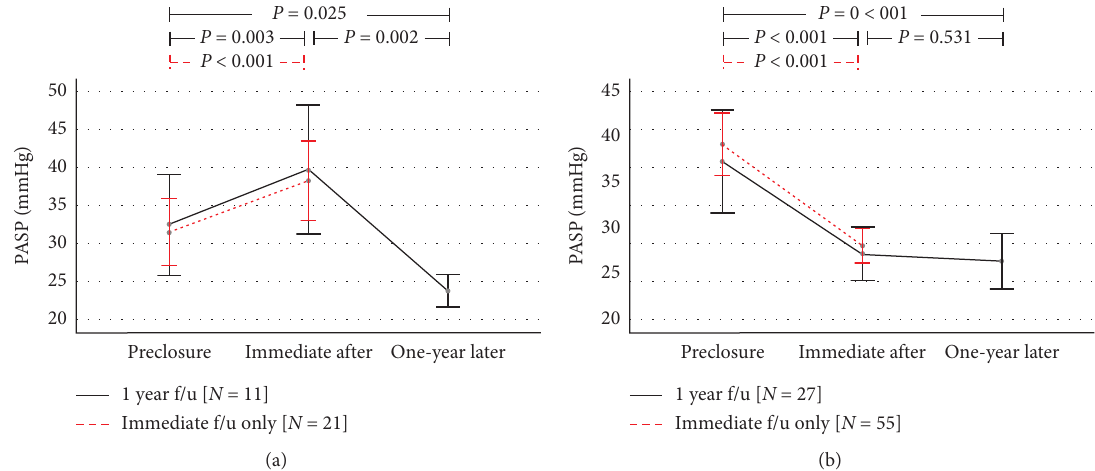
Figure 3: Serial changes in pulmonary arterial systolic pressure (PASP) from preclosure stage to one-year follow-up by immediate PASP response group: (a) immediately increased PASP group; (b) immediately decreased PASP group. Blue dotted line represents comparisons between preclosure state and immediately after (one-day after closure) follow-up only. Bars represent 95% confidence